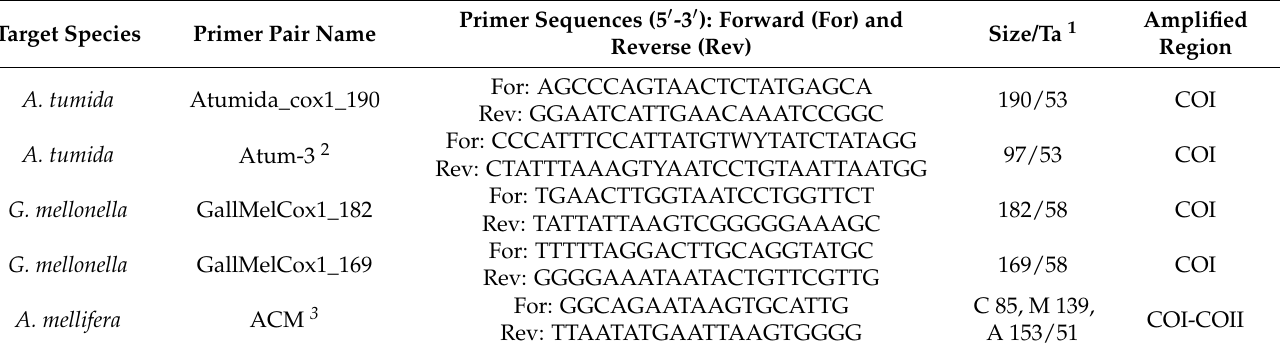
Table 1. PCR primers, PCR conditions and amplified mitochondrial DNA